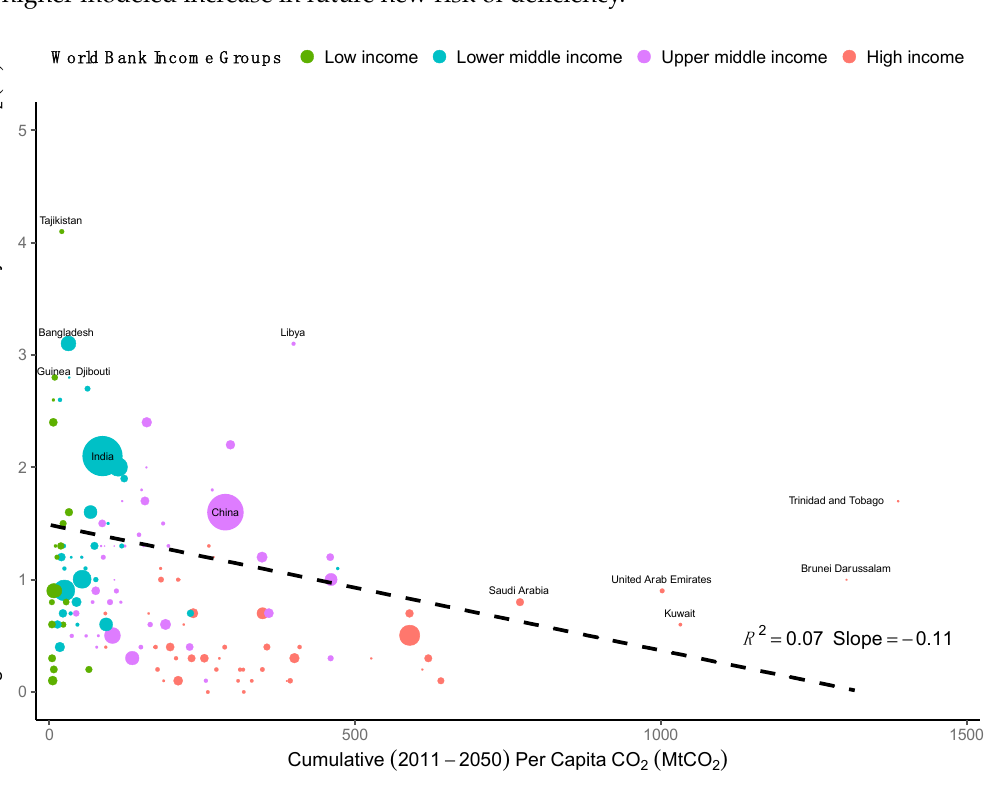
Figure 2. Population-weighted association between cumulative per capita CO 2 emissions and percentage increase in the population at risk of protein deficiency with elevated CO 2 for 146 countries between 2011 and 2050 with select individual countries labeled. Bubble sizes depict the population prospect for each country in 2050 [19]. Note. CO 2 = Carbon dioxide; MtCO 2 = Metric tons of carbon dioxide.